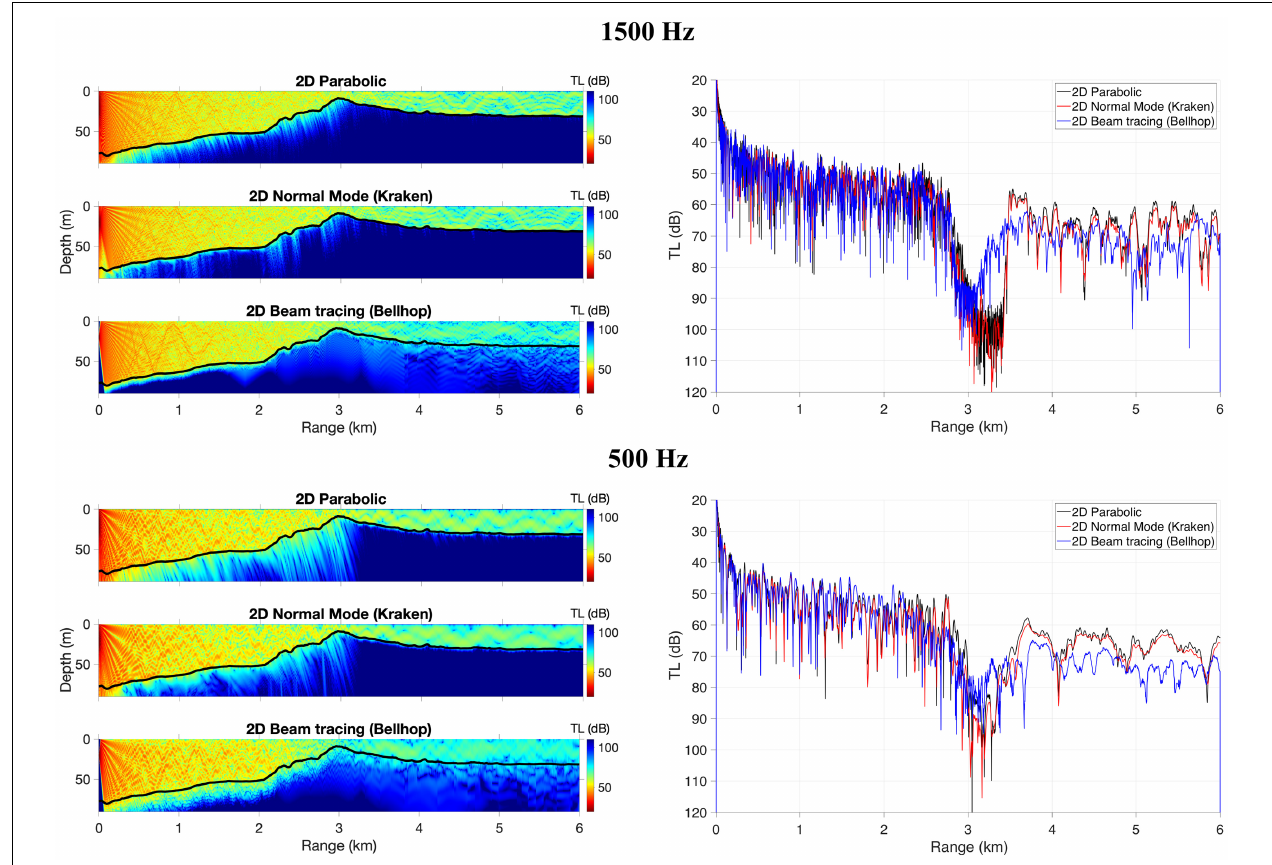
FIGURE 6 | Transmission loss for a 1500 Hz (top panel) and 500 Hz (bottom panel) sound source propagating over a sand bar with an SSP range-dependent [ c ( r , z ) ] waveguide. Plots on the right present TL over the range at 20 m water depth. Results are presented for 2D parabolic, 2D normal mode (Kraken, mode coupling), and 2D beam tracing